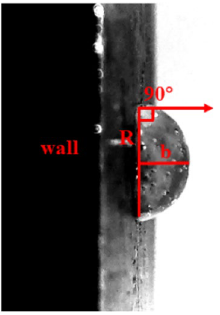
Figure 3. Droplet contact angle and